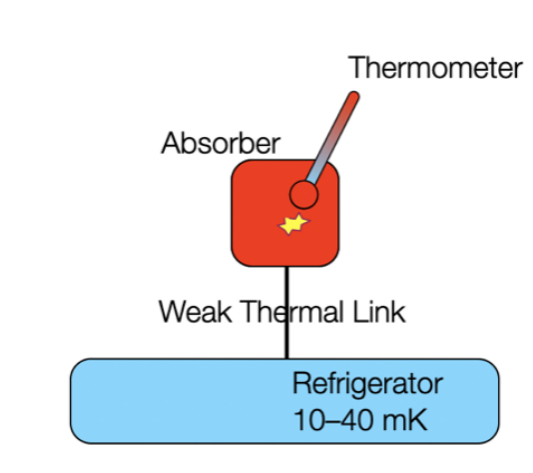
Figure 32: Schematic of a generic cryogenic detector. A thermometer measures the temperature of an absorber that has a weak thermal link to a refrigerator. The mea- sured temperature increase is proportional to the deposited energy divided by the heat capacity of the absorber. Figure courtesy of Matt